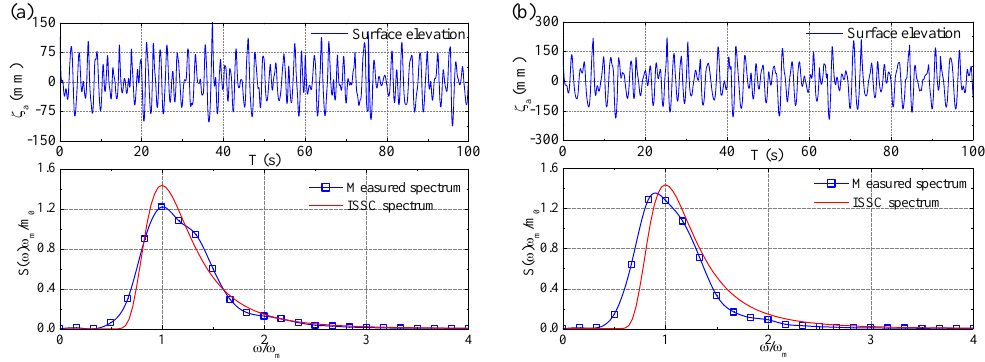
Figure 27. Wave data for small-scale model test: ( a ) the design sea state; and ( b ) the extreme sea state.